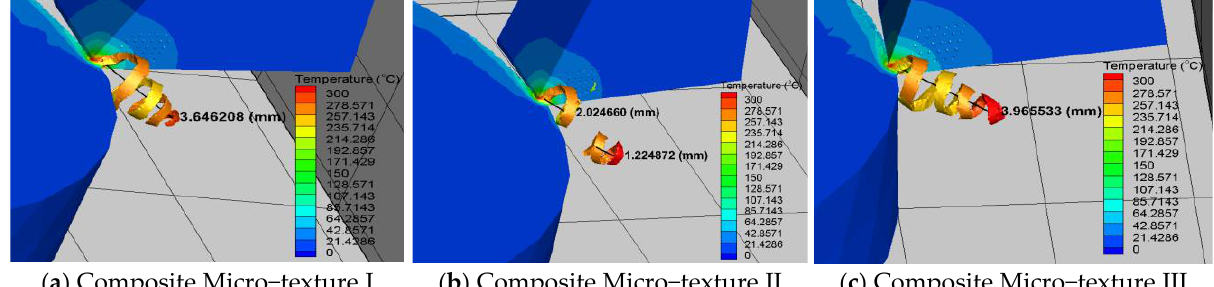
Figure 8. Chip morphology of three composite micro−textured tools.